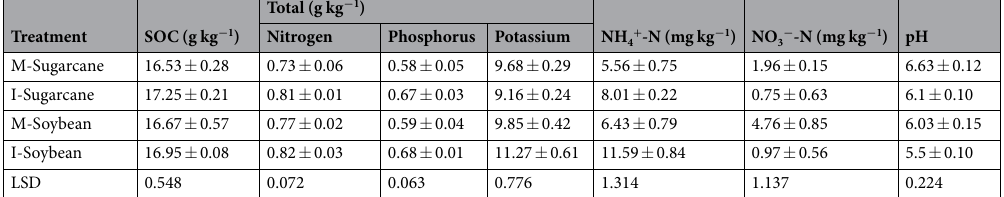
Table 1. General chemical characteristics of the soil. Values are the means ± SE (n = 3). M-Sugarcane, sugarcane monoculture; I-Sugarcane, intercropped sugarcane. M-Soybean, soybean monoculture; I-Soybean, intercropped